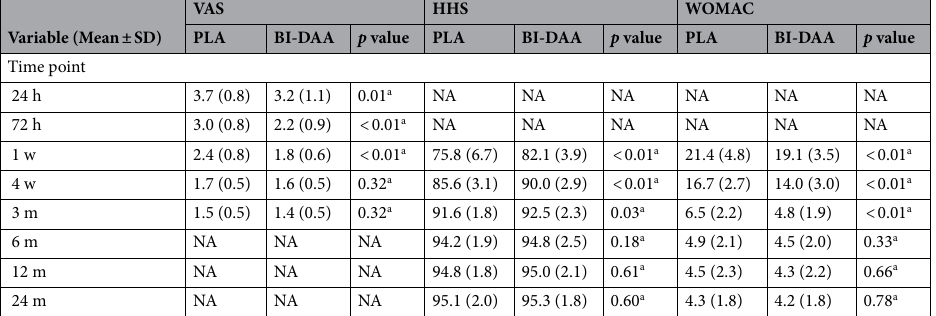
Table 4. Postoperative pain and functional outcomes. Values are mean (SD). p value < 0.05 considered statistically significant. VAS visual analogue scale, HHS harris hip score, WOMAC the western ontario